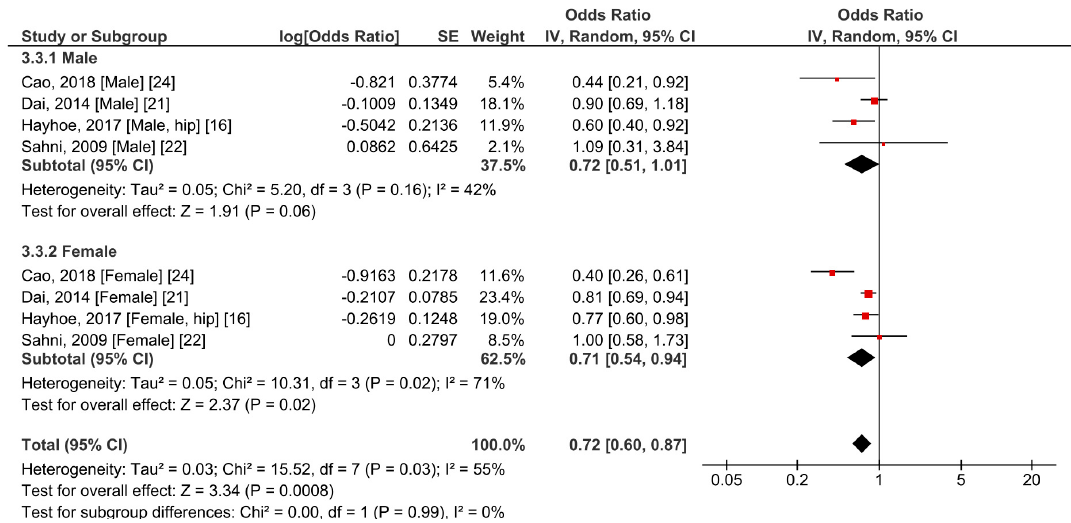
Kingdom and the United States); ( b ) Asia (Singapore, Korea, Japan, and China).